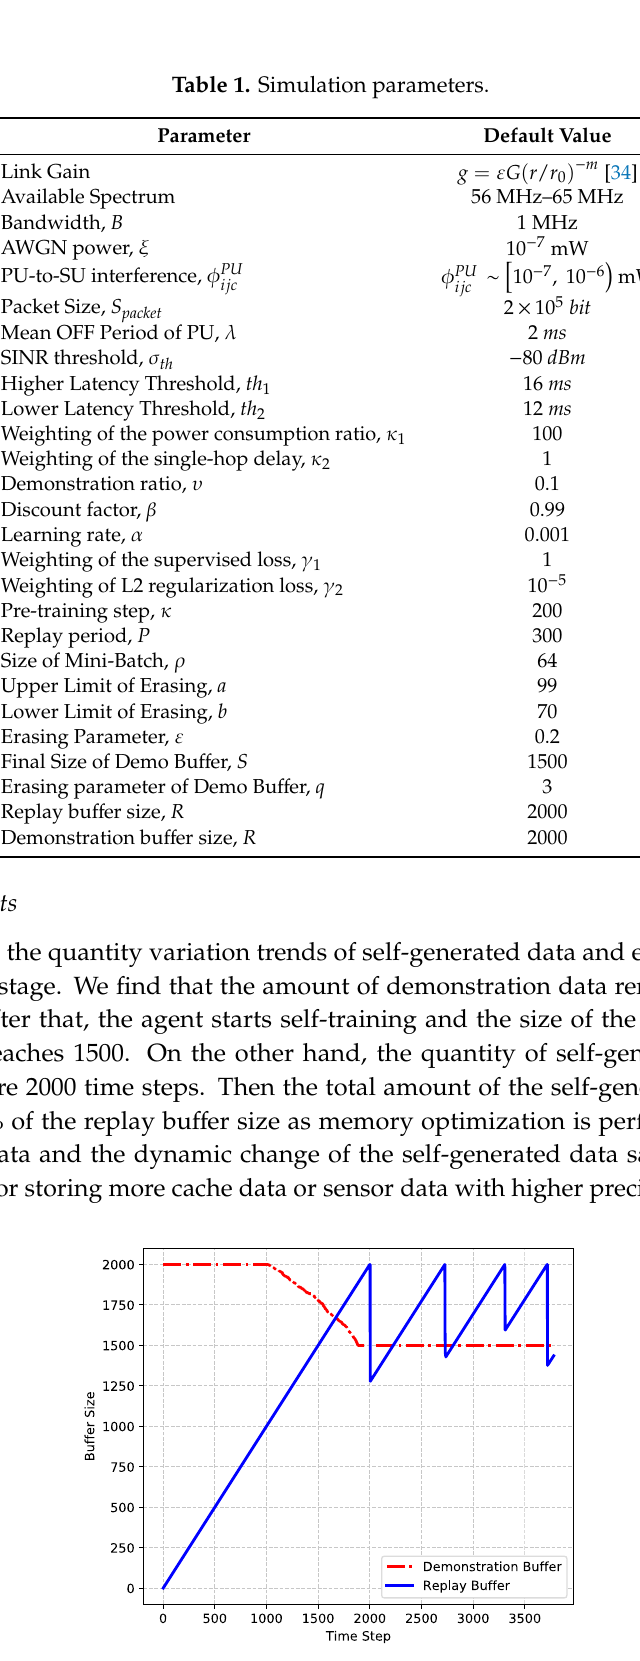
Figure 6. Quantity variation trends of self-generated data and demonstration data.